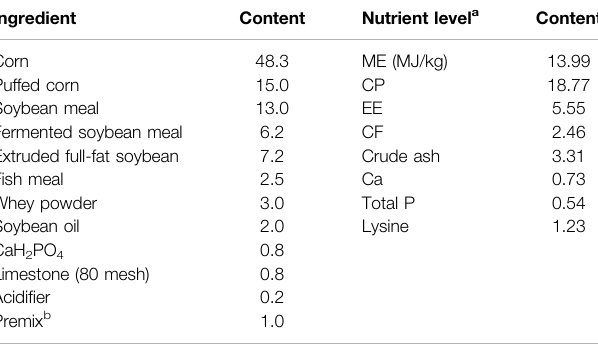
TABLE 1 | Composition and nutrient levels of the basal diet (air-dry basis,